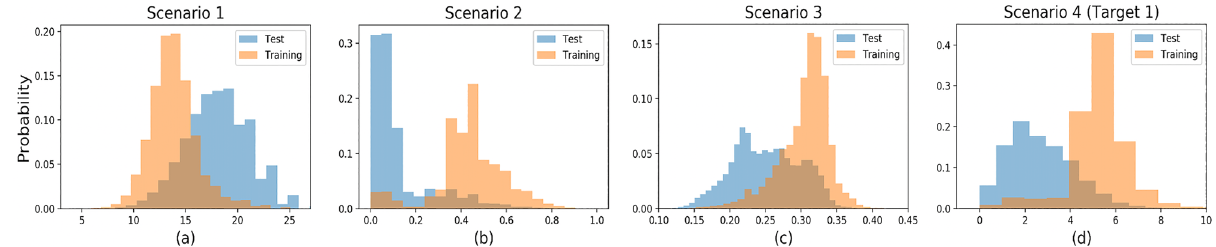
Figure 5. Average densities of the training and test datasets of QM9. The x -axises correspond to (a) number of atoms, (b) proportion of double/triple/aromatic bonds, (c) value of HOMO-LUMO gap (gap), and (d) value of mu,